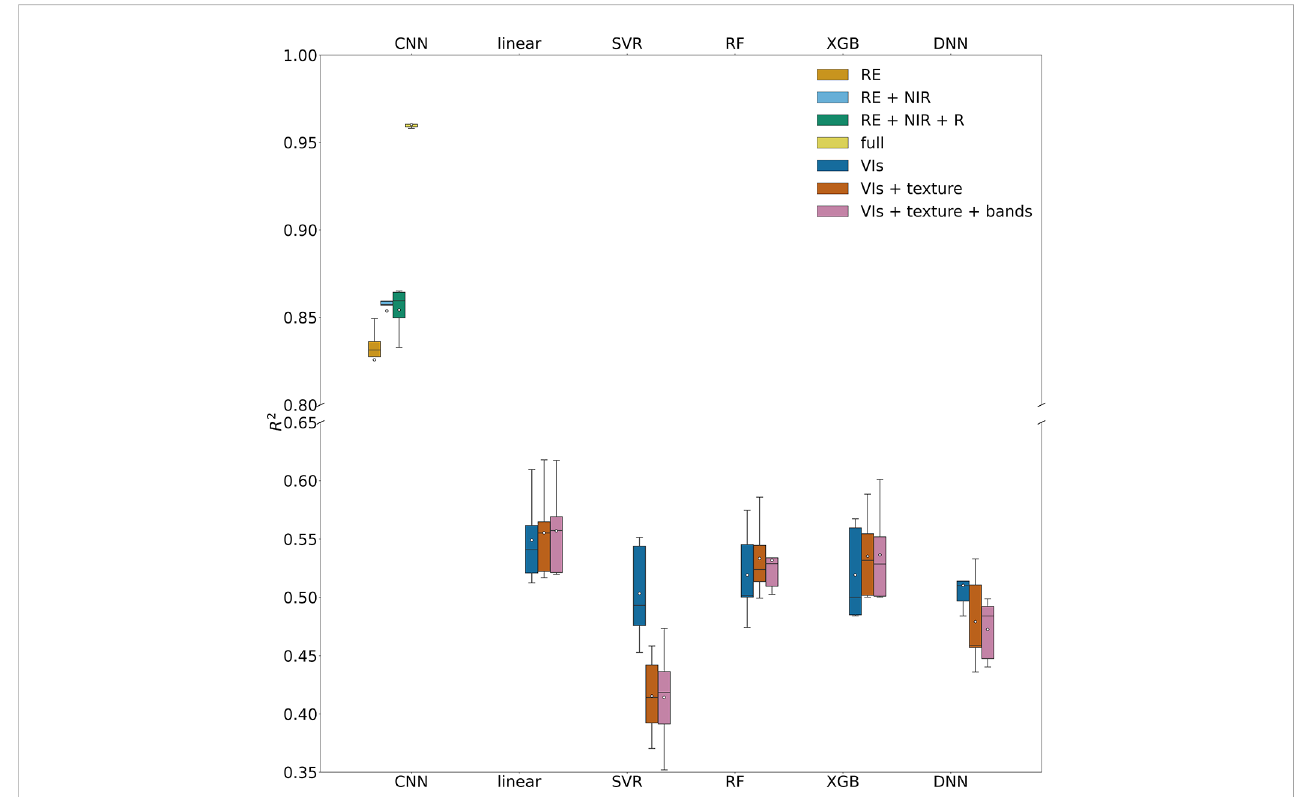
FIGURE 7 Model performance in predicting tree level yield, quanti fi ed by R 2 with the test data set, for CNN models with different spectral bands and machine learning models with different combinations of input